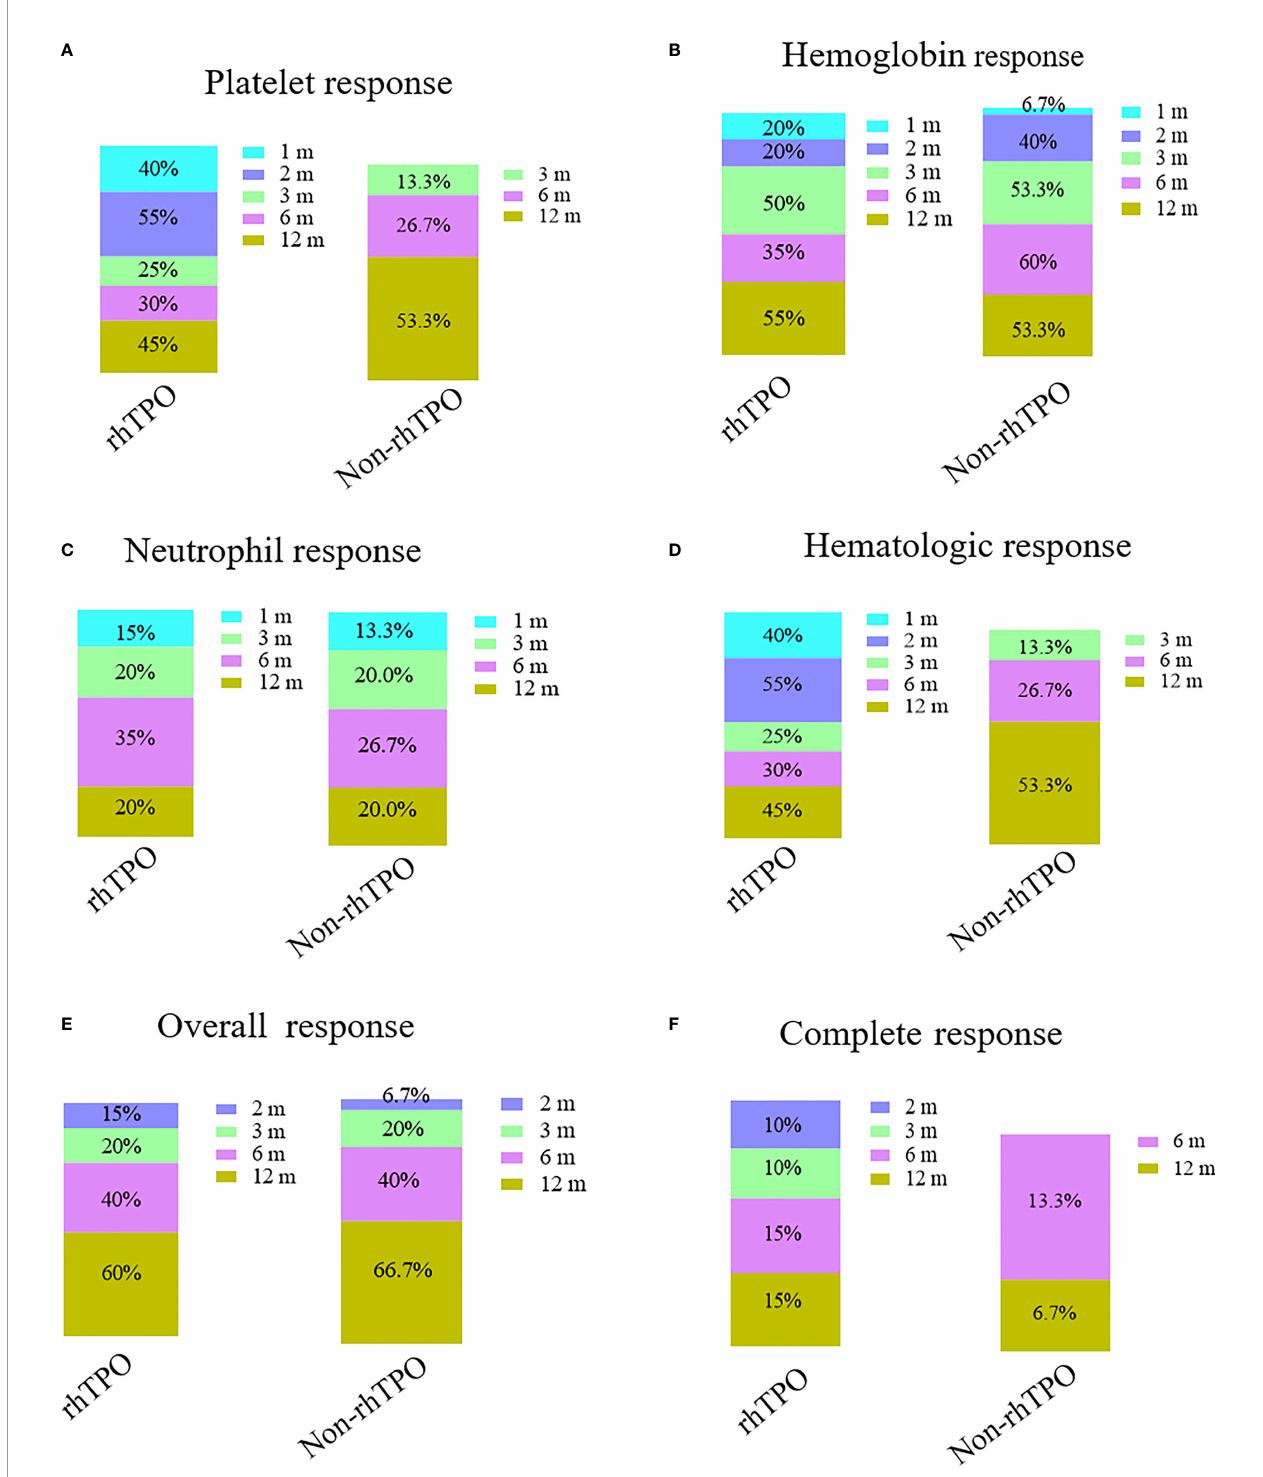
FIGURE 2 | Bar plots showing the therapy response rates at different time points in the recombinant human thrombopoietin (rhTPO) group and the non-rhTPO group. Platelet response (A) , hemoglobin response (B) , neutrophil response (C) , hematologic response (D) , complete response (E) , and overall response (F) rates at 1, 2, 3, 6, and 12 months in the rhTPO and non-rhTPO